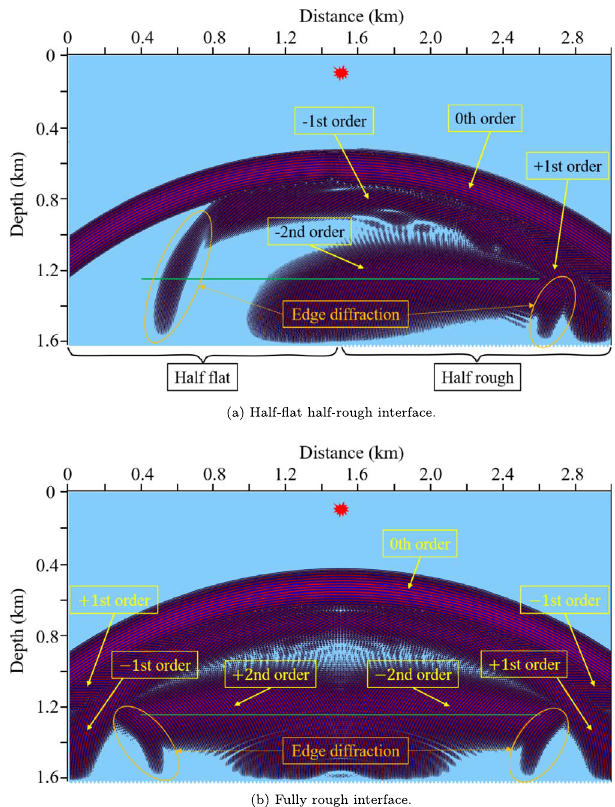
Figure 2. Snapshots (at time (a) t = 1.74 s, (b) t = 1.8 s) of the wave fi elds after re fl ection of the incident wave fi eld from (a) a half- fl at half-rough interface, (b) a fully rough interface. The source location is indicated by a red star, while the horizontal array of receivers is indicated by a green line.